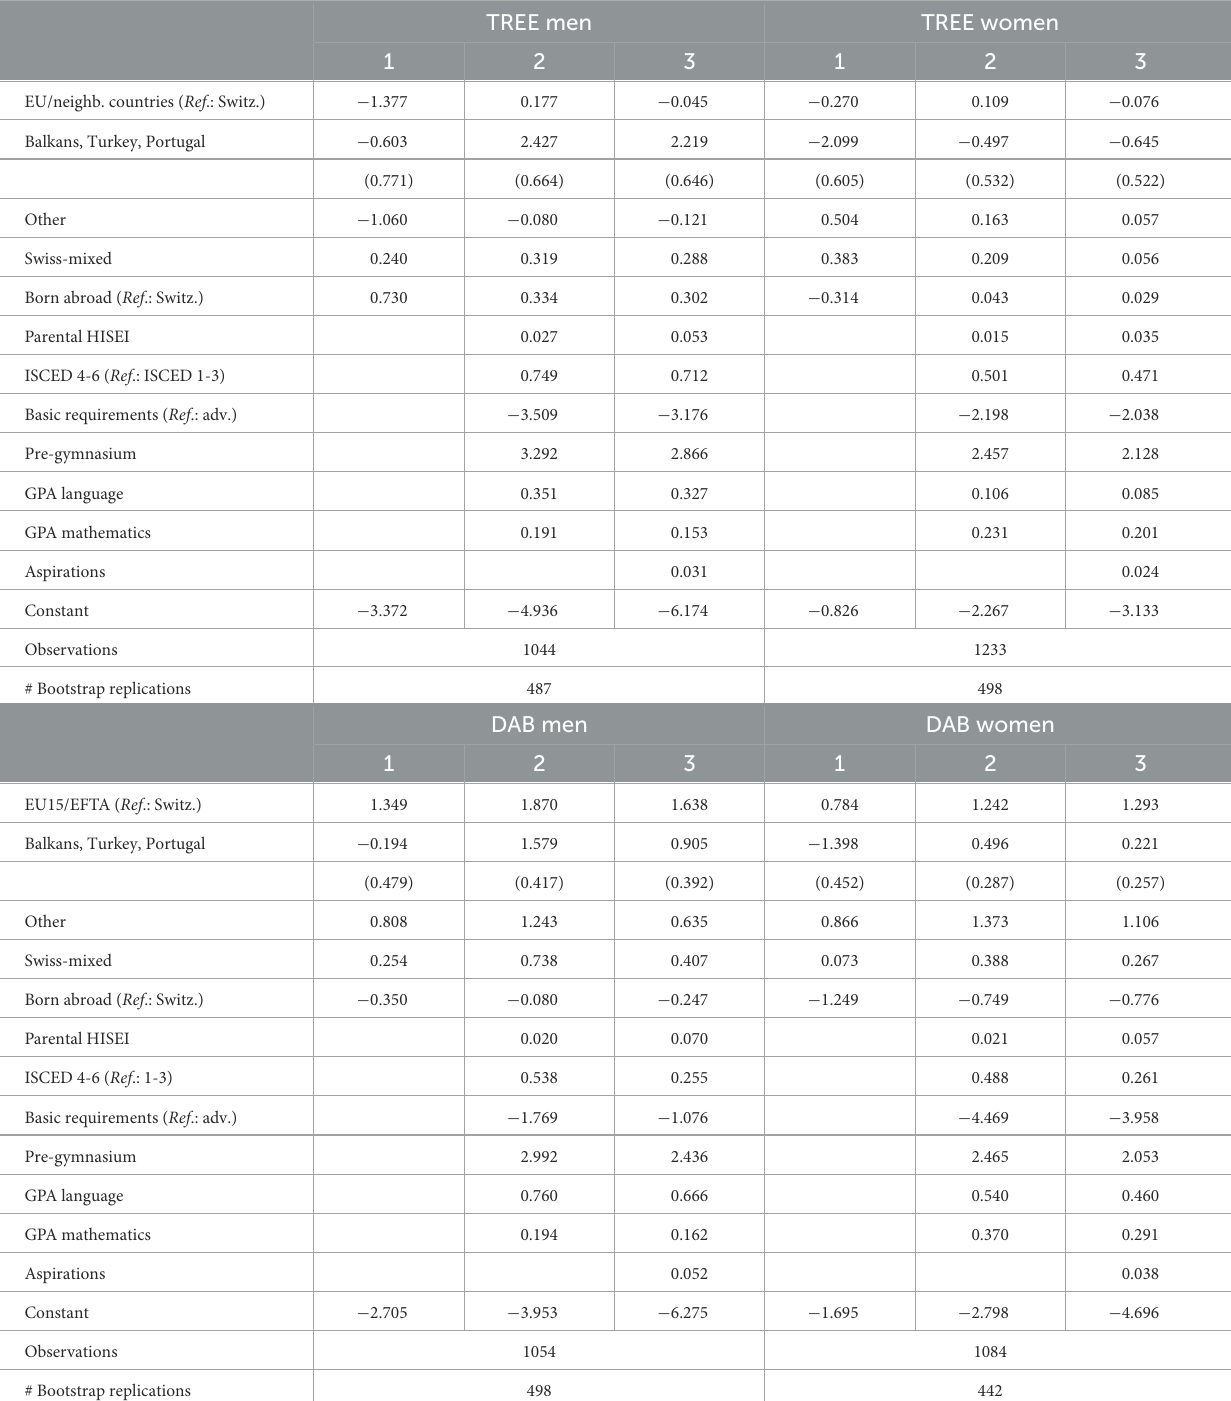
TABLE 1 Educational situation two years (TREE)/15 months (DAB) after leaving compulsory education (0 = VET; 1 = academic track). TREE men TREE